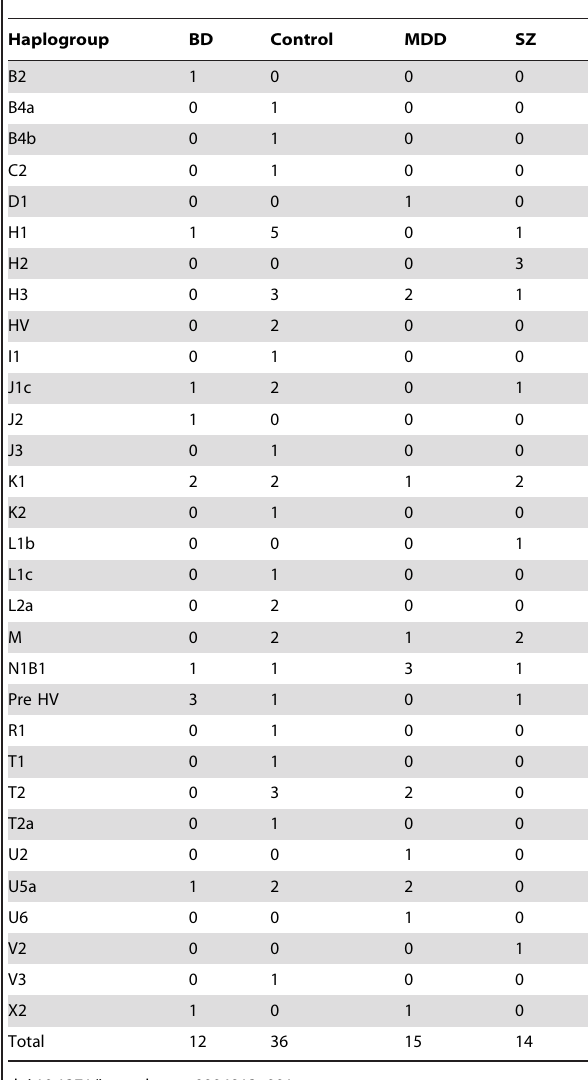
Table 1. The haplogroup determination of mtDNA derived from DLPFC showed 31 diverse haplogroups that could be reconstructed.